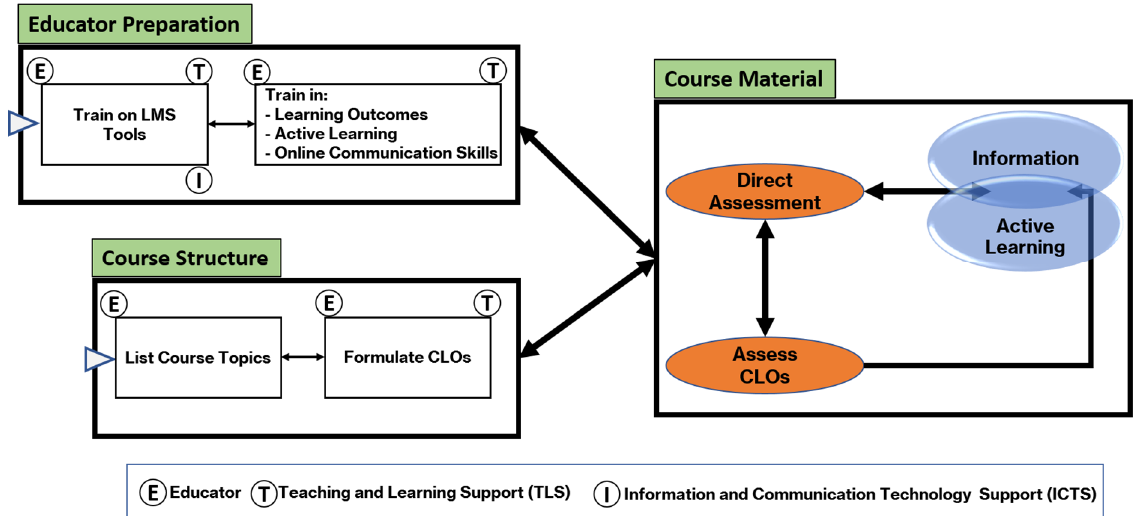
Figure 3. A protocol for designing class material, learning methods, and direct assessments.